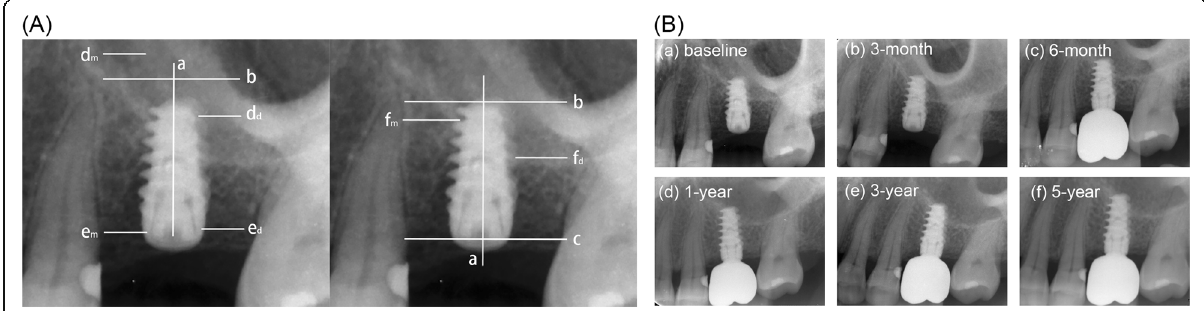
Fig. 1 a Radiographic assessment. Reference lines were drawn as follows: ( a ) Implant longitudinal axis; ( b ) implant apex line: the most apical level of the implant, vertical to ( a ); ( c ) implant coronal line: the level of implant-to-abutment contact, vertical to ( a ); ( d ) Apical bone line: the most apical level of the new bone in the sinus, vertical to ( a ), at the mesial site (d m ) and at the distal site (d d ); ( e ) crest bone line: the most coronal level of bone-to-implant contact, vertical to ( a ), at the mesial site (e m ) and at the distal site (e d ); ( f) Sinus floor line: the most coronal level of sinus floor cortical bone, vertical to ( a ) , at the mesial site (f m ) and at the distal site (f d ). b Endo-sinus bone remodeling after non-grafting